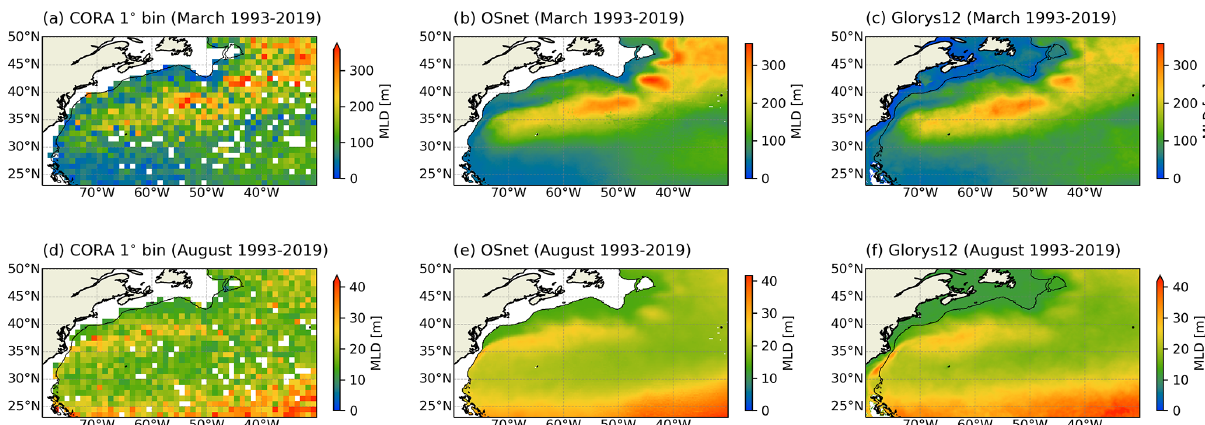
Figure 9. Maps of the monthly mean of the MLD defined with a density threshold of 0.03kgm − 3 for (a, d) CORA T − S profiles averaged by bins of 1 ◦ (b, e) OSnet and (c, f) Glorys12. The months of March and August are representative of the seasonal range of the MLD for the region. Note the different color-bar range for each month. The maximum of the color bar is set by the maximum of OSnet. The shelf break is traced in black with the bathymetry contour of